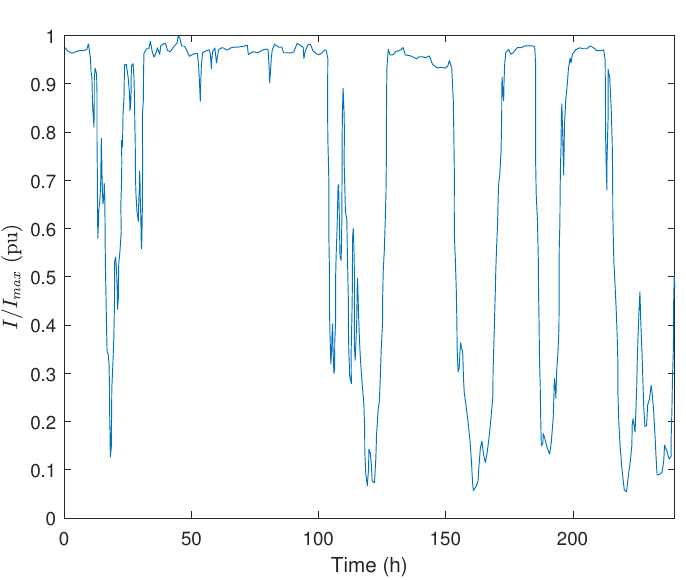
Figure 8. Normalized load profile.